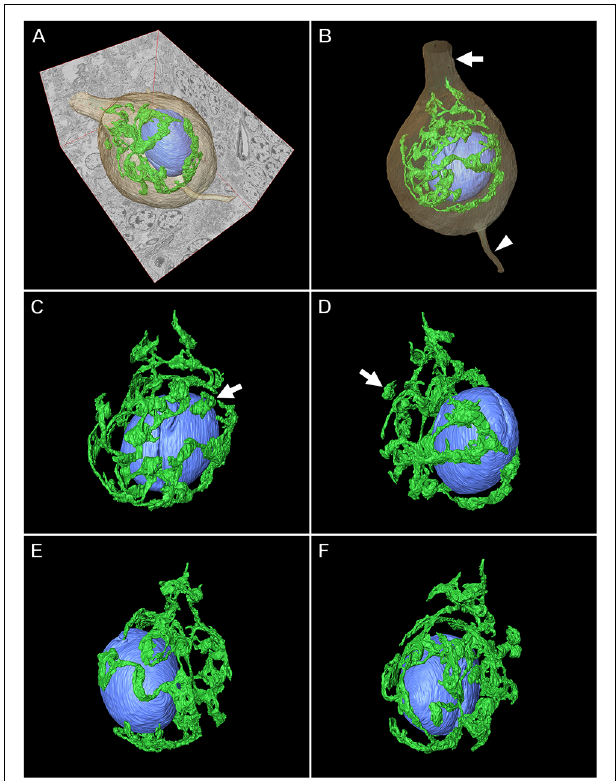
FIGURE 9 | Three-dimensional (3D) reconstruction image of a Purkinje cell in the rat cerebellum. (A,B) Surface rendering models of the Golgi apparatus (green), nucleus (blue), and soma (brown) of the Purkinje cell created from 281 serial tomographic images obtained using BSE-mode SEM. The arrow and arrowhead indicate the dendrite and axon, respectively. Various angle views of the 3D model of the Golgi apparatus and nucleus are shown in (C) , (D) , (E) , and (F) . The Golgi apparatus in the Purkinje cell comprises a principally continuous basket-like structure that surrounds the nucleus. Arrows show discontinuous stacks of the Golgi